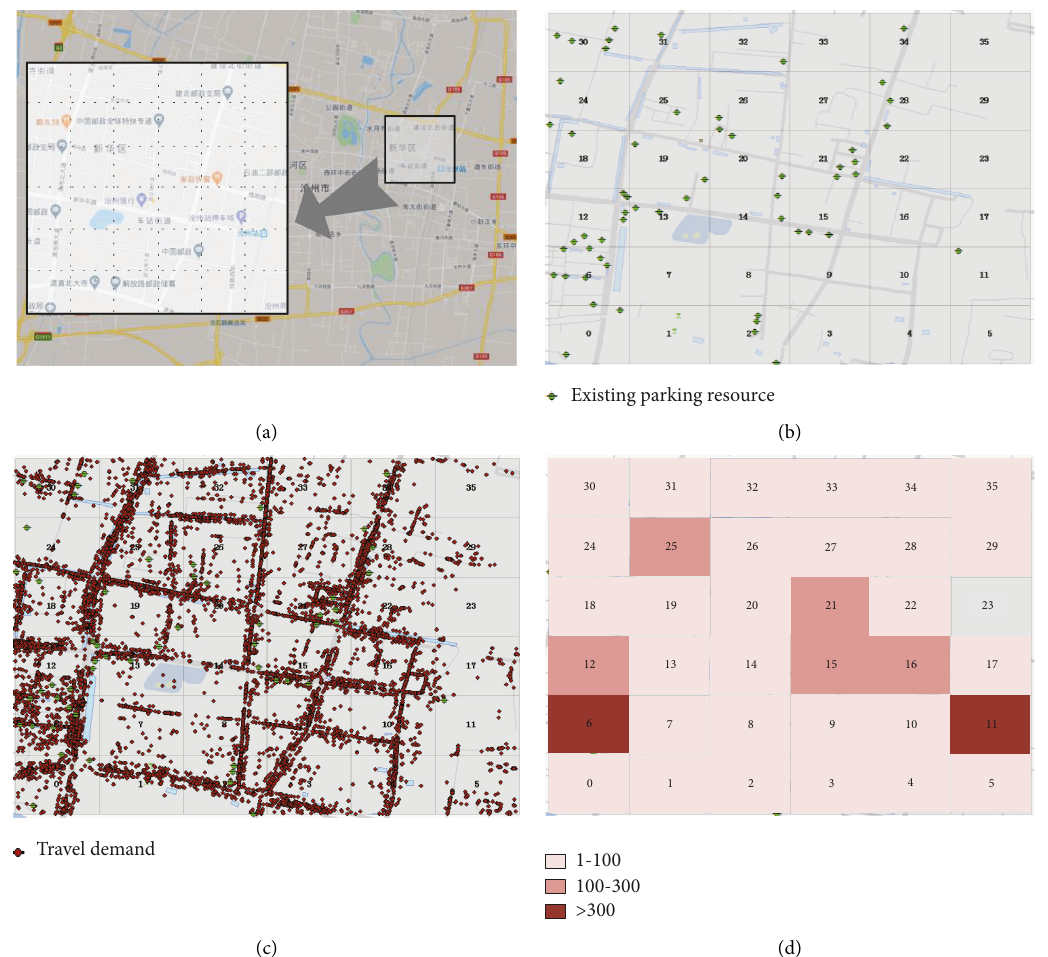
Figure 5: The data preprocessing and parking demand estimation. (a) Study area and grid split. (b) Mapping existing parking resource into grids. (c) Mapping travel demand data into grids. (d) The estimated parking